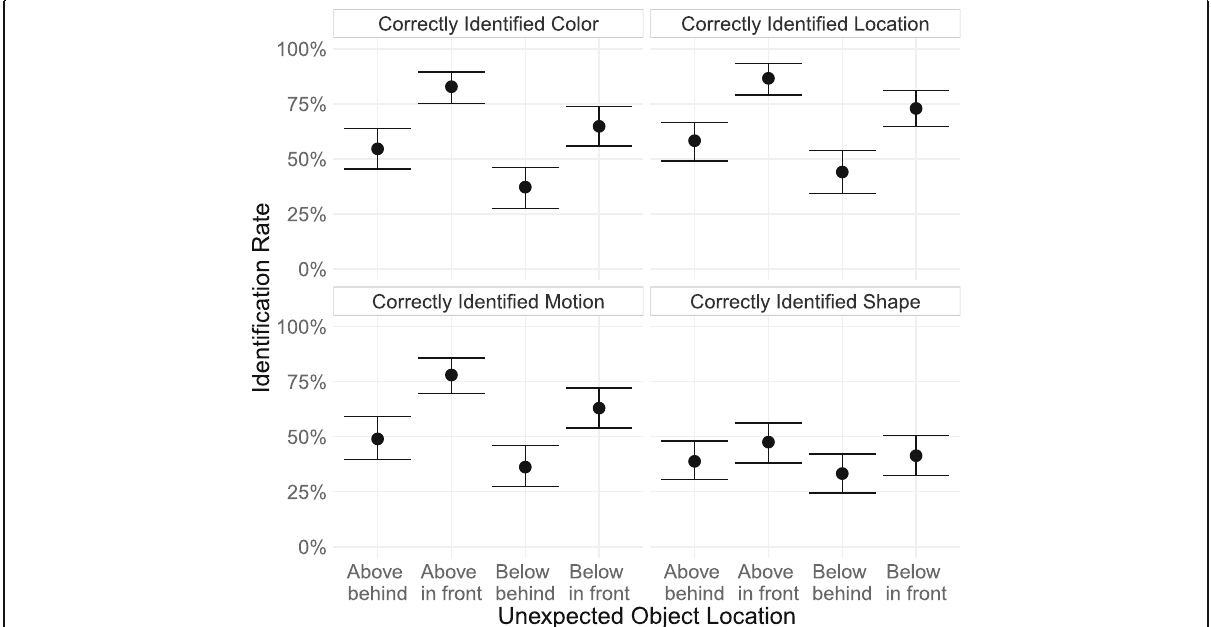
Fig. 3 Rate at which subjects who reported seeing a new object correctly identified the unexpected object ’ s features, broken down by each possible position. Error bars are 95% bootstrapped confidence intervals. To be counted as correctly identifying a feature of the unexpected object, subjects had to report noticing something new, and: for color, report that the new object was green; for location, report whether the object appeared above or below their avatar; for motion, report that the object was not moving; and for shape, report that it was a